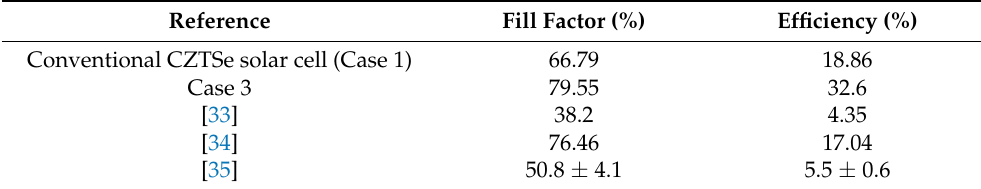
Table 4. Comparation results of the proposed solar cell with previously published solar cells.